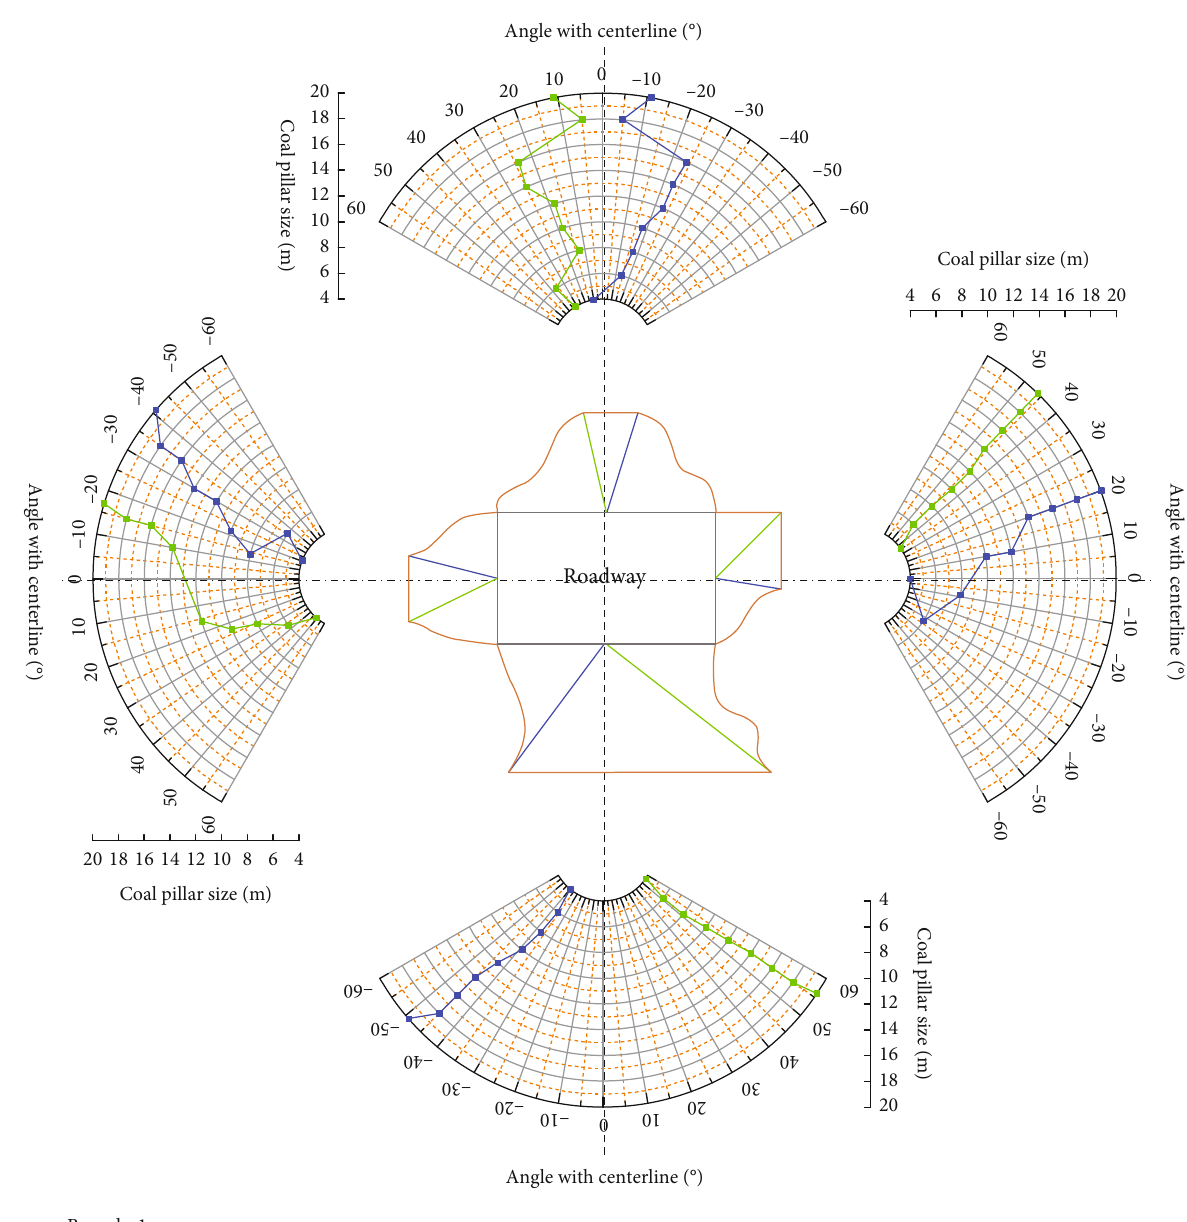
Figure 7: Location of maximum failure depth in plastic zone of roadway surrounding